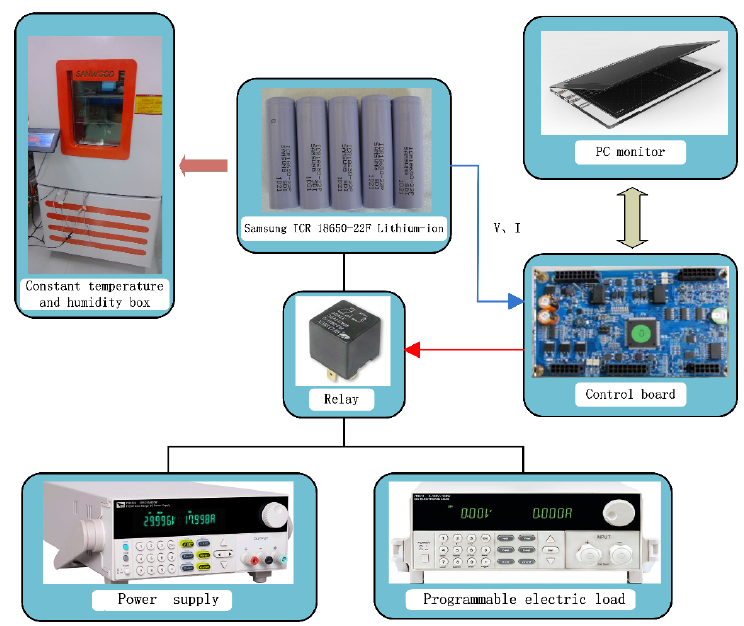
Figure 4. Schematic of battery test bench.